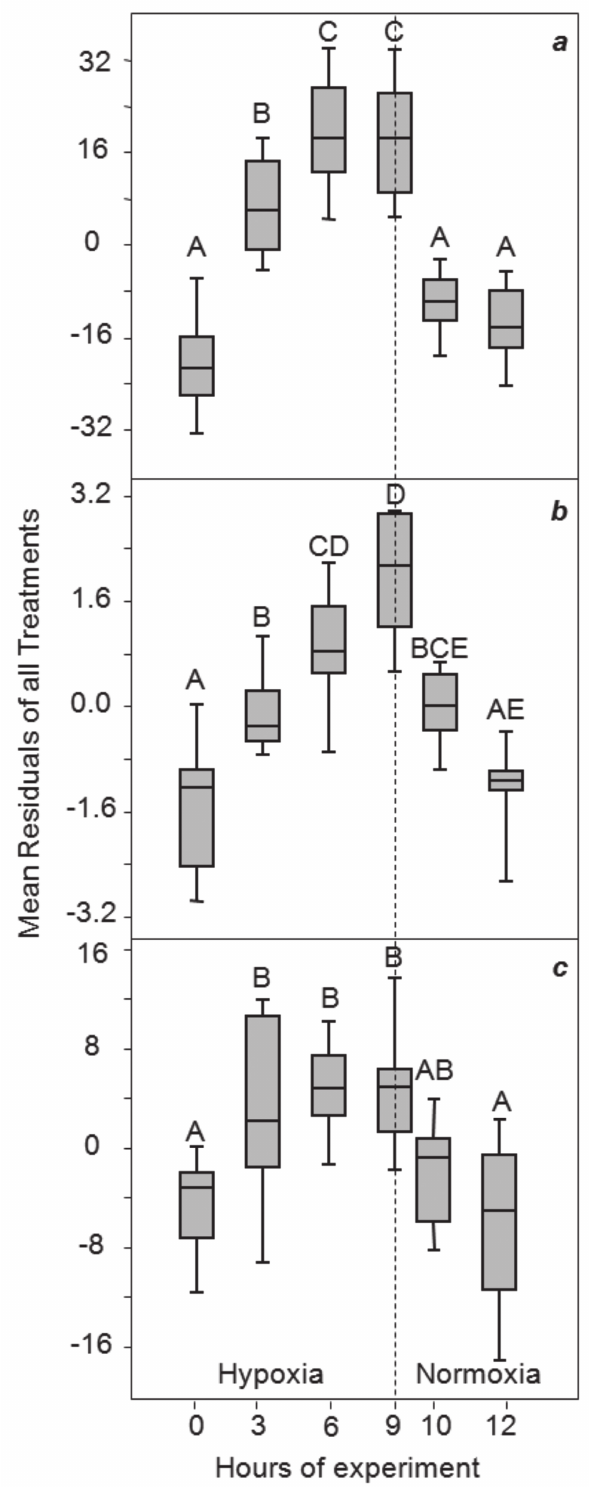
Fig. 1. Development and reversion of the three morphological variables exposed to nine hours of hypoxia, followed by three hours of normoxia in Piaractus mesopotamicus . (a) lower lip, (b) maxillary, and (c) opercular valve. Capital letters above box plots indicate groups in multiple comparisons (Tukey’s tests) after repeated measures